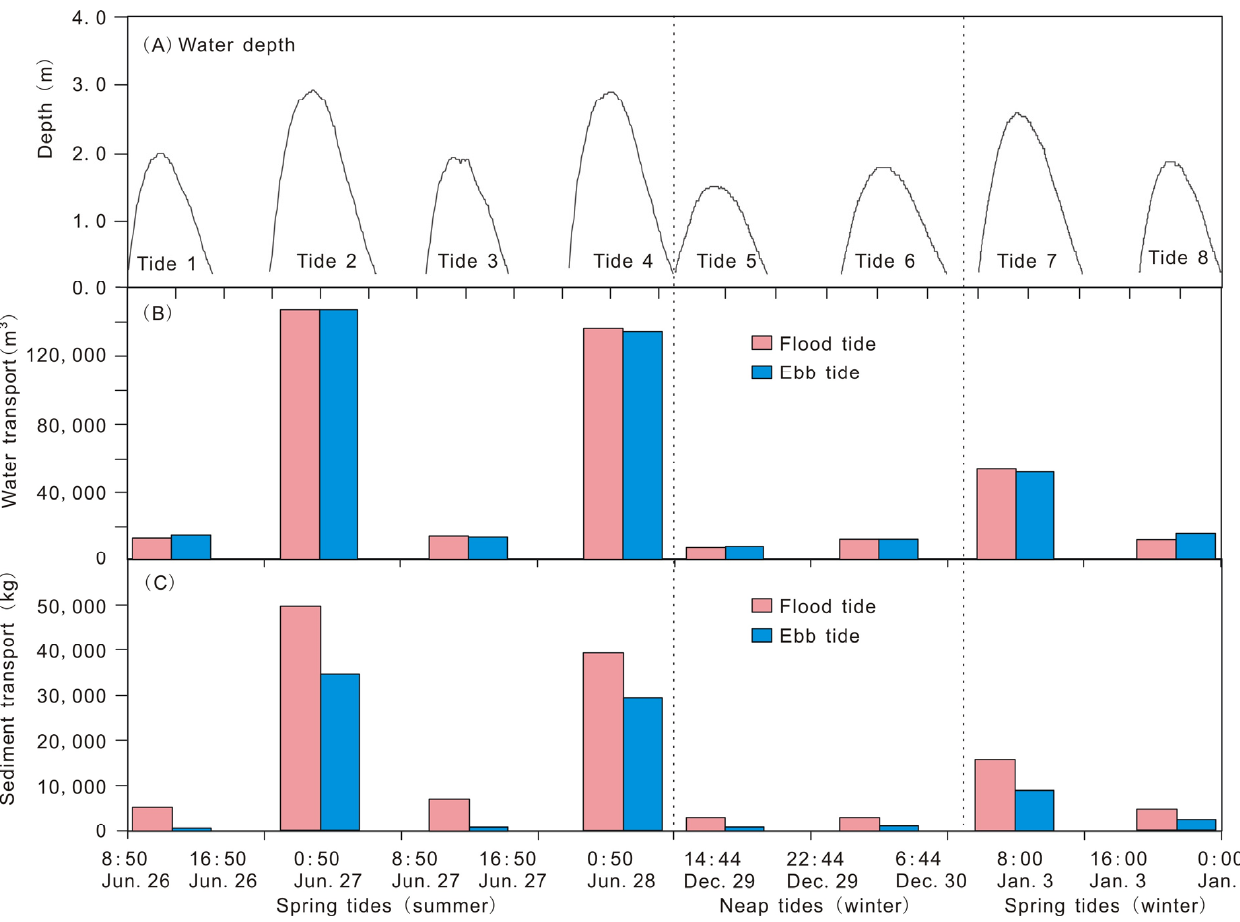
Figure 6. Time series of water depth ( A ), Water transport ( B ) and sediment transport ( C ) into and out of the tidal basin through the tidal creek during flood and ebb phases.